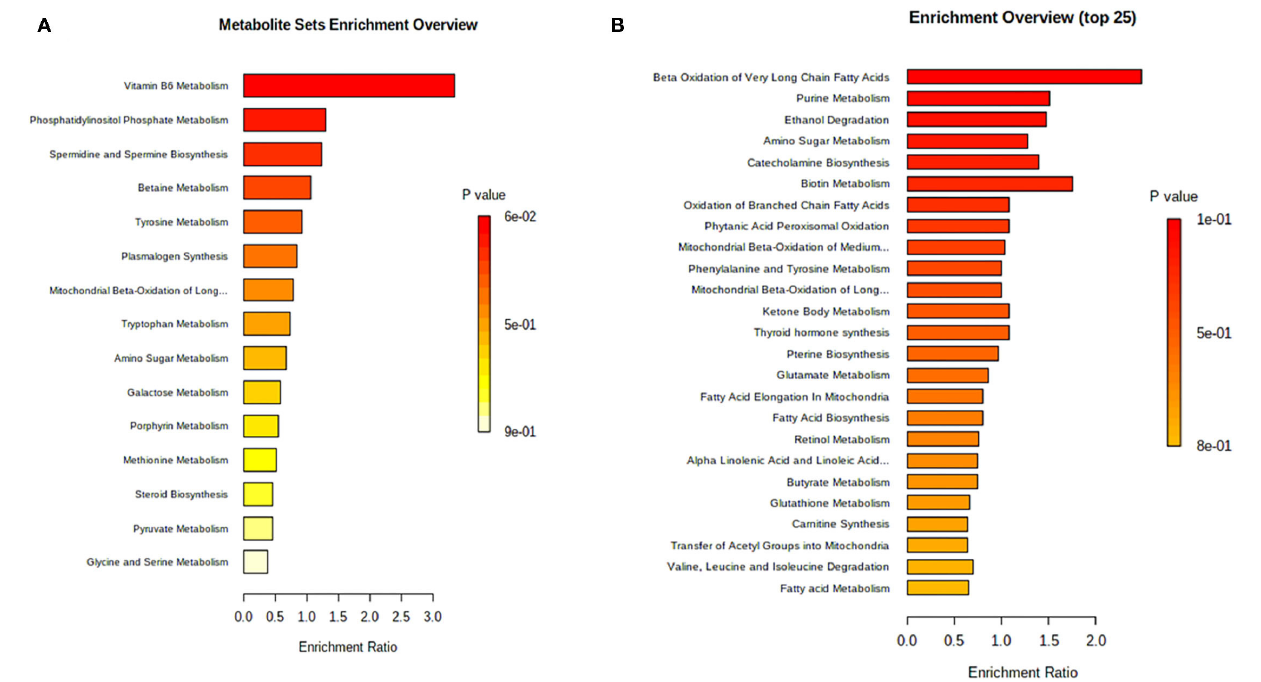
FIGURE 4 | Functional enrichment analysis on differential ruminal metabolites. (A) Functional enrichment analysis on differential ruminal metabolites between CON and HS treatments. CON, control treatment; HS, heat stress treatment; p < 0.05 was considered as significant difference. (B) Functional enrichment analysis on differential ruminal metabolites after honeycomb flavonoids supplement under heat stress conditions. CON, control treatment; HS, heat stress treatment; p < 0.05 was considered as significant difference.